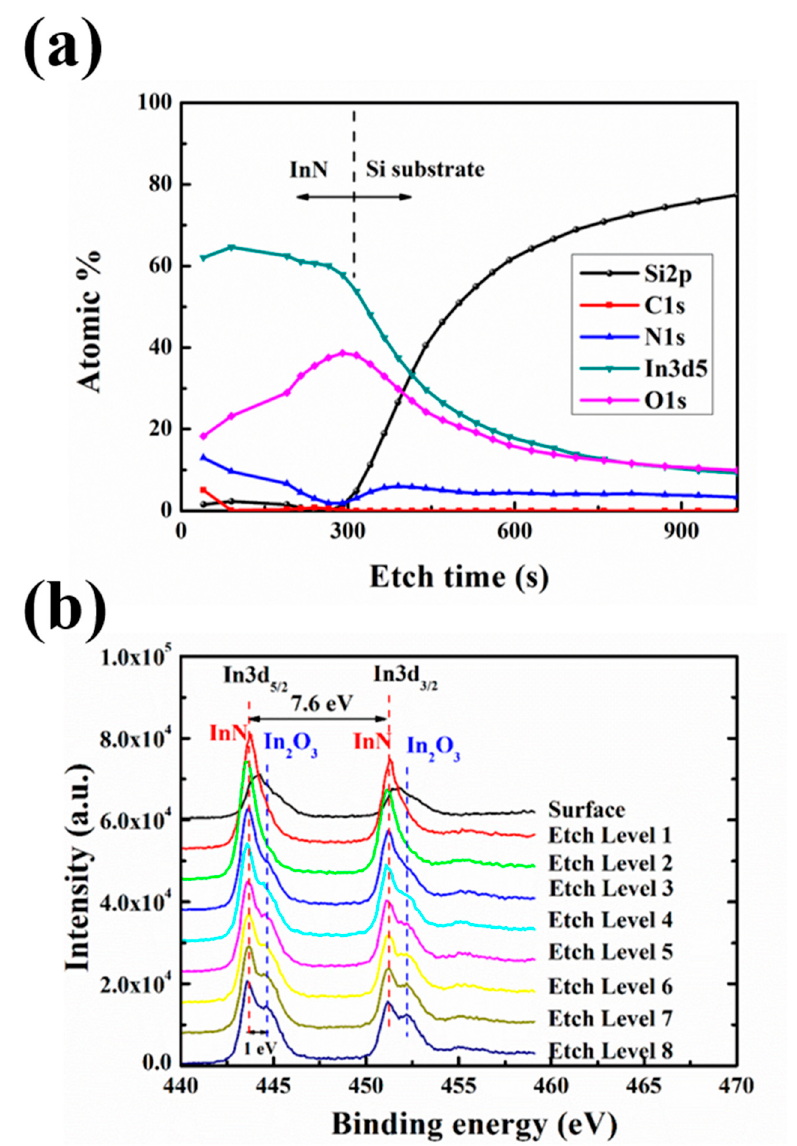
Figure 4. ( a ) XPS depth profile and ( b ) In3d spectra of InN nanocolumns grown on a nitrided Si(111) substrate at 520 °C.